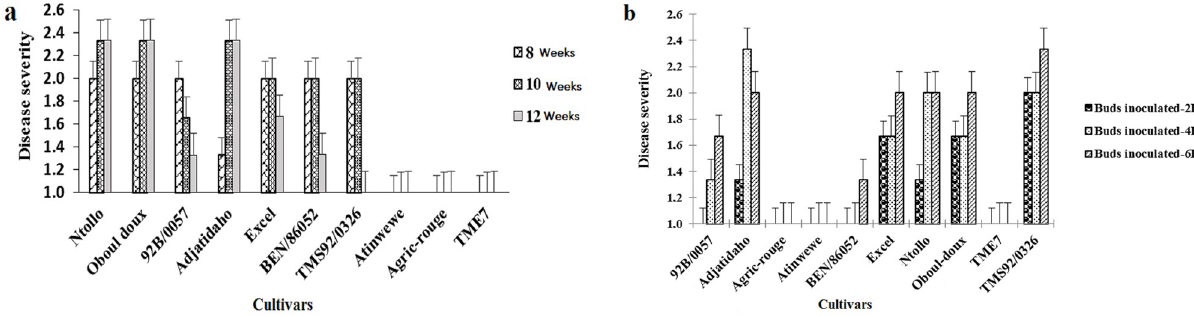
Fig 6. Variation in cassava mosaic disease severity among cassava cultivars: Effect of age at inoculation (a) and inoculum dose (b).